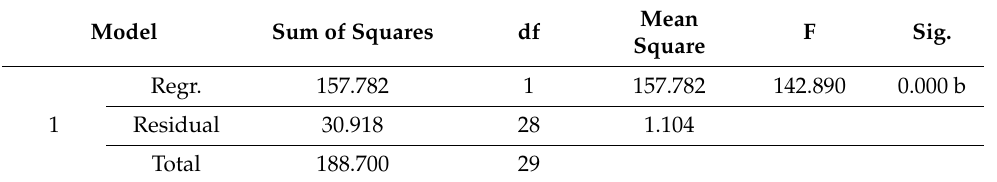
Table 7. E-court user satisfaction and user